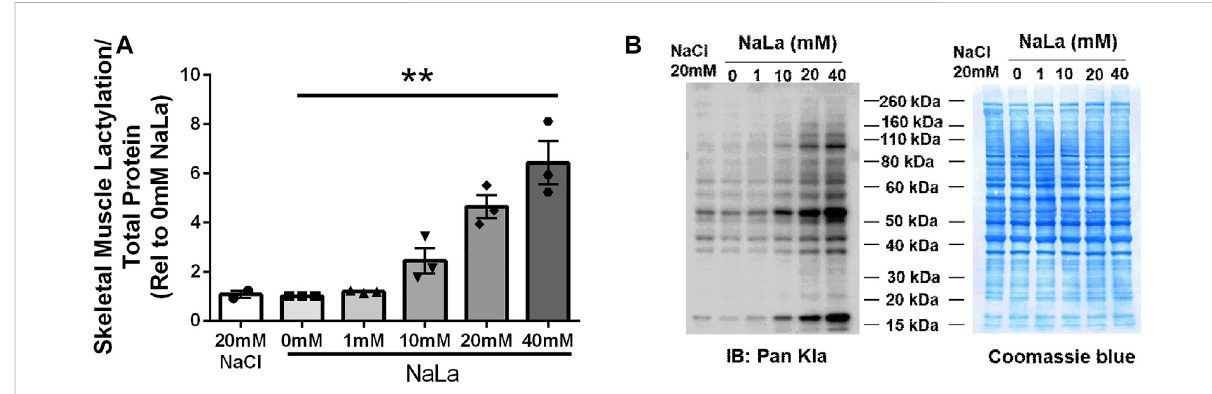
FIGURE 4 Lactate-Induced Lactylation in Primary Humans Skeletal Muscle Cells. Quanti fi cation of lactylation in human primary skeletal muscle cells in response to increasing sodium lactate concentrations (n = 3 for NaLa dose response, n = 2 for NaCl control) (A) . Myotube lactylation levels were normalizedtoCoomassieBlue.Representativeblotforpan-klaandCoomassieblue (B) .Dataisexpressedasmean±SEM.** p < 0.005maineffectfor lactate dose. Sample size (n) represents biological replicates from HSkMC derived from different